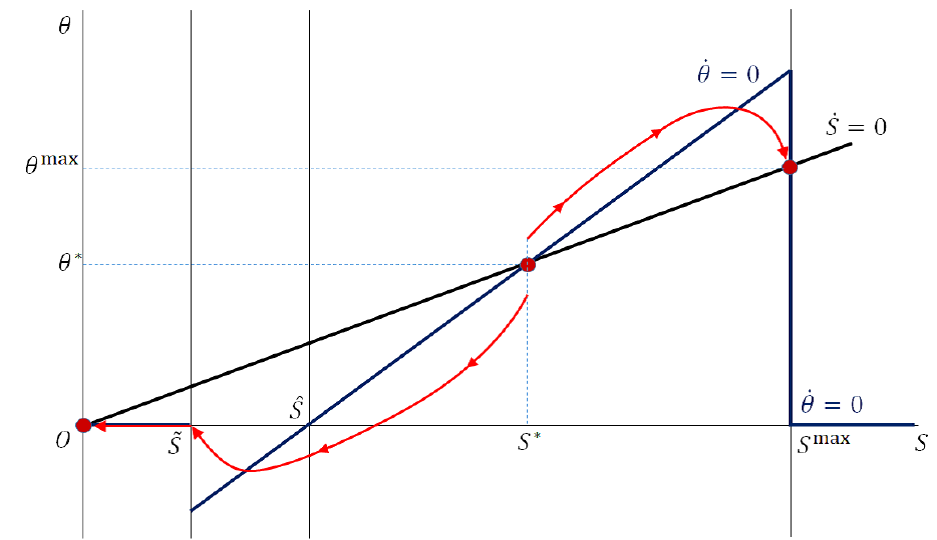
Figure 5. History-dependent